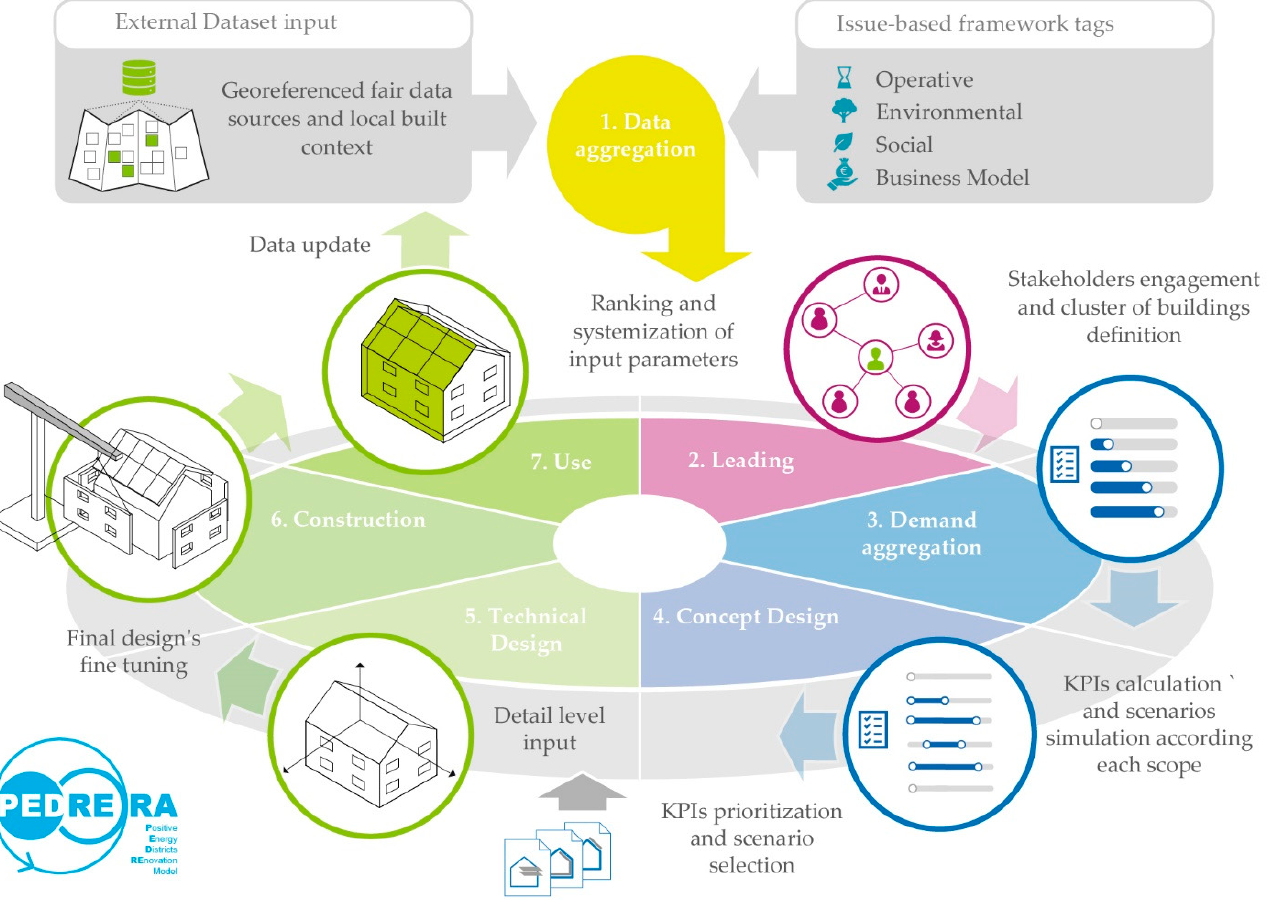
Figure 1. Synthesis of the renovation process flowchart and the interactive approach with the PEDRERA model. Source: PEDRERA.